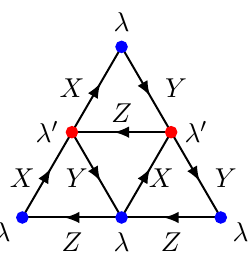
Figure 7 . The adjacency diagram of the dilute RSOS model associated to the Z 2 quiver theory, in the dynamical N = 4 -like picture. Vertices of the same colour/height λ are identified. This is the dual graph to the brane-tiling diagram of the quiver